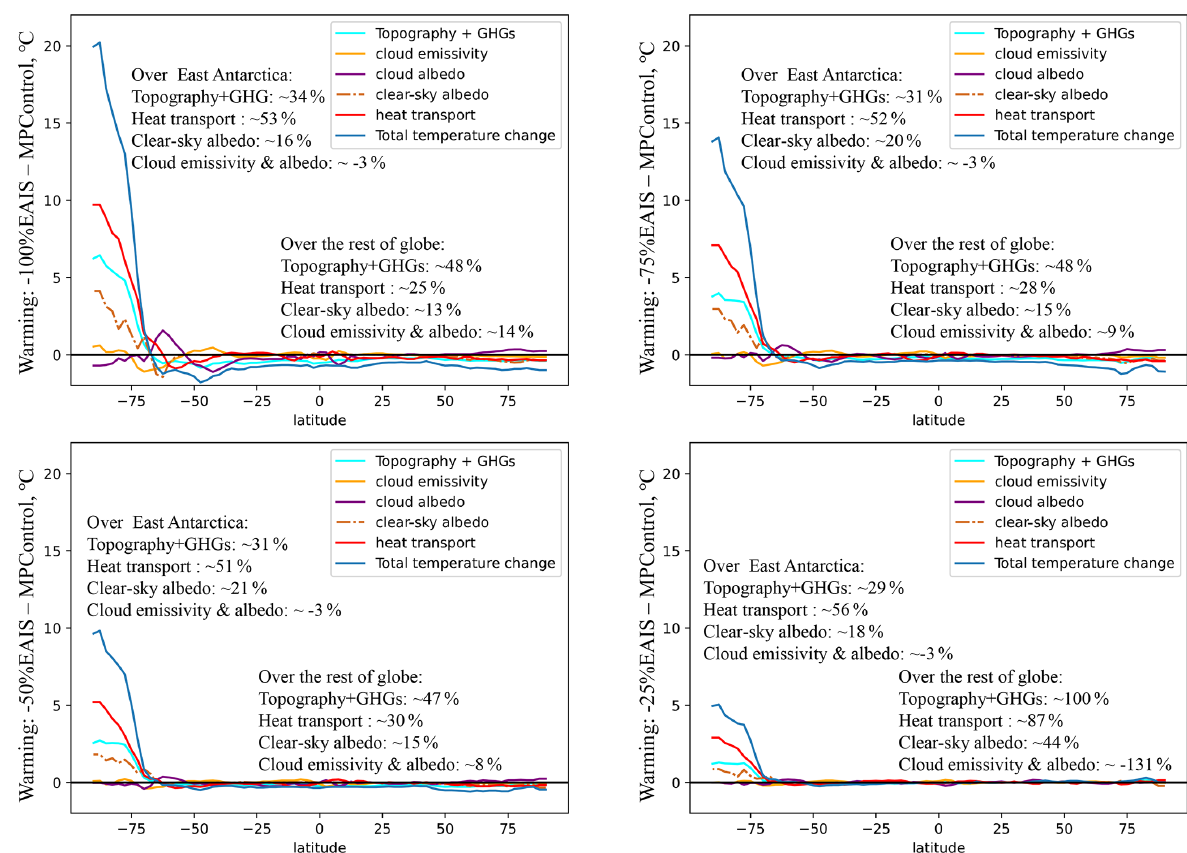
Figure 8. Energy balance analysis between the sensitivity experiments and the MPControl. Plot shows the zonal mean warming and cooling at each latitude from each of the energy balance components. GHGs stands for greenhouse gases. The percentage value represents the contribution of each energy balance component to the temperature changes over East Antarctica and the rest of